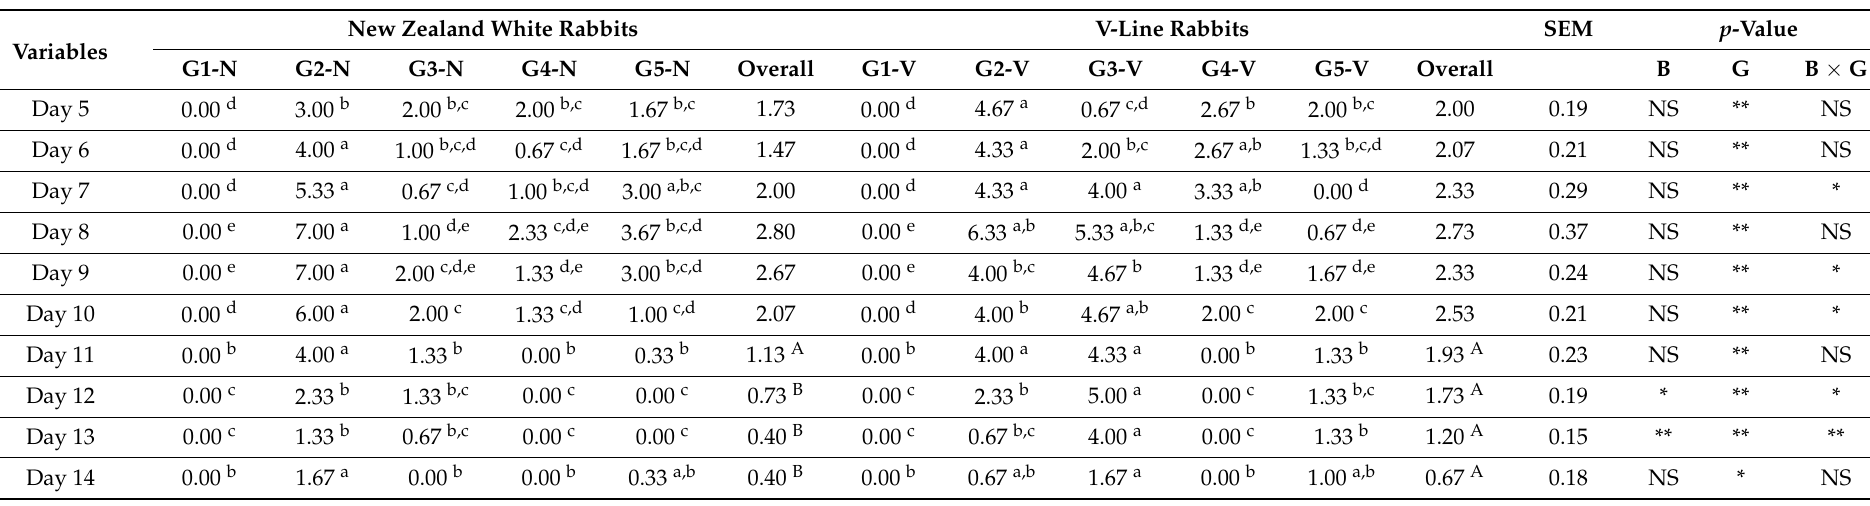
Table 3. Fecal score of the New Zealand white and V-line rabbits in response to coccidial infection and herbal extract treatment. New Zealand White Rabbits V-Line Rabbits SEM p Variables